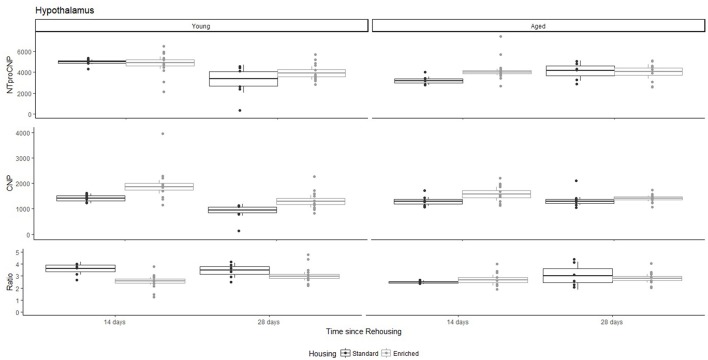
Concentration (femtomoles/g wet tissue) of NTproCNP (Top), CNP (Middle), and NTproCNP:CNP ratio (Bottom) within hypothalamus. Summary data is 20% trimmed means (resulting in a reduction of n = 2 for all groups), standard error (box) and 95% confidence interval (whisker), overlaid by individual data points. For NTproCNP: Young-14-day > Young-28-day. For CNP: Young-Enriched-14-day > Aged overall = Other Young rats. For Ratio: Young-Enriched-14-day < Young-Standard. Aged overall < Other Young rats.